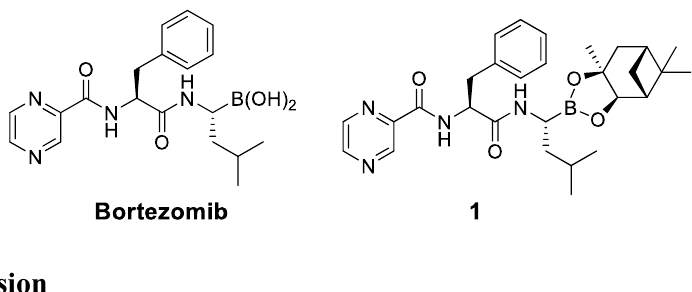
Figure 1. Chemical structures of bortezomib and compound 1